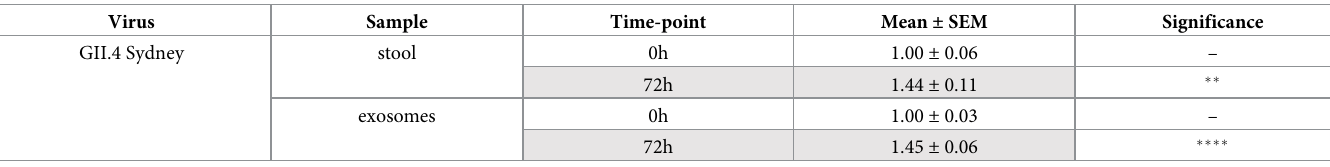
Table 3. Infected Vero cells release HuNoV-loaded exosomes.